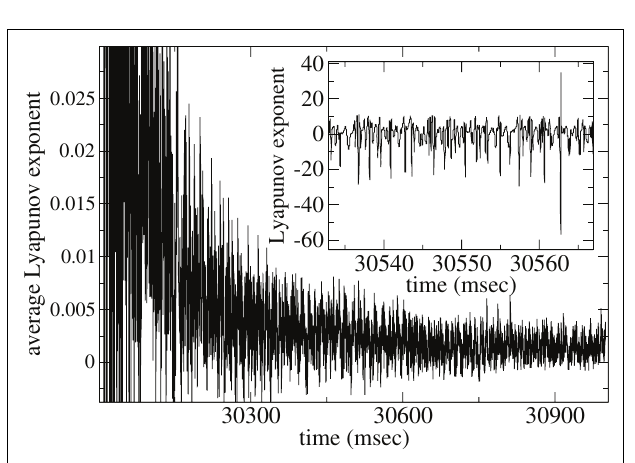
FIGURE 15 | Lyapunov exponent γ calculation for single network deterministic simulation. Inset shows γ , main shows (cid:3) γ (cid:4) . Connectivity ρ = 0.1, α = 1.5, r C = 0.02, b C = 0.0006, τ without